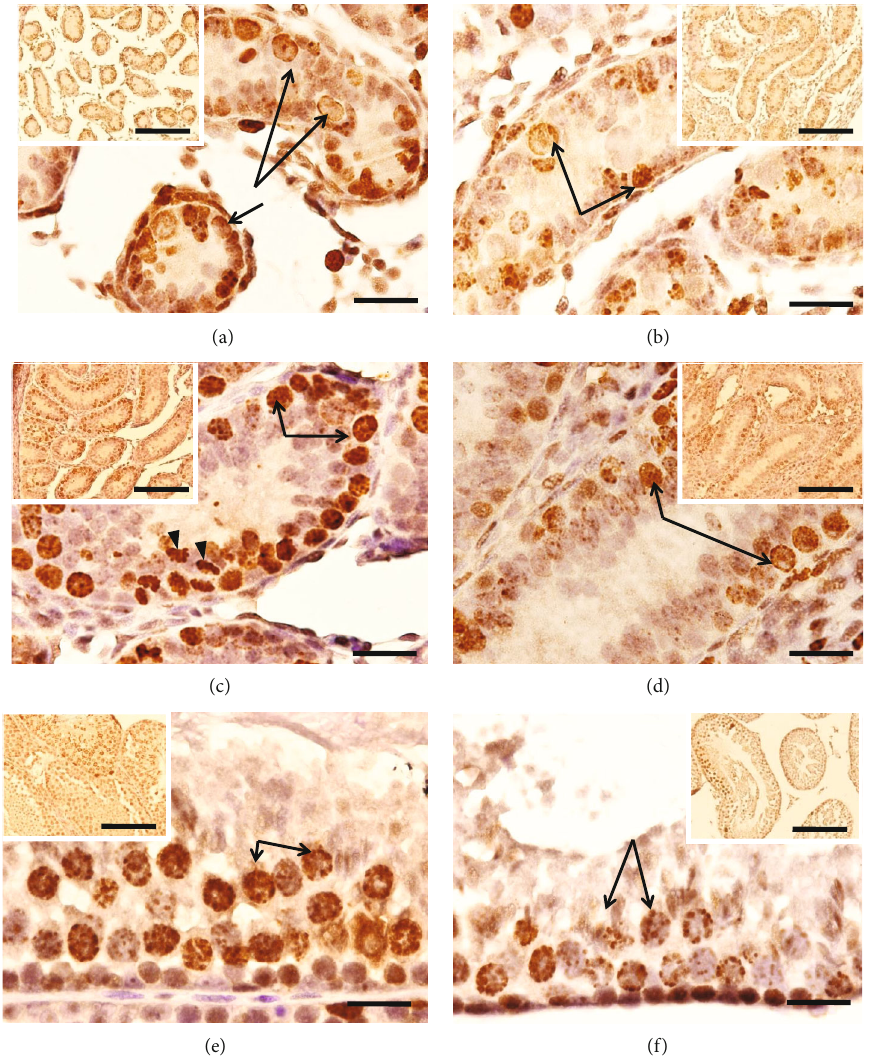
Figure 3: Seminiferous cords/tubules of mice: (a) control of 3 dpp, (b) nicotine group of 3 dpp, (c) control of 10dpp, (d) nicotine of 10 dpp, (e) control of 35 dpp, and (f) the nicotine group of 35 dpp. A greater number of immunoreactive germ cells to phospho-histone H3 protein can be observed (arrow) in the seminiferous cords/tubules of control animals with respect to the nicotine group. Anaphase (arrowhead). Immunohistochemical study: bar scale: 20 μ m, insertion bar scale: 150 μ